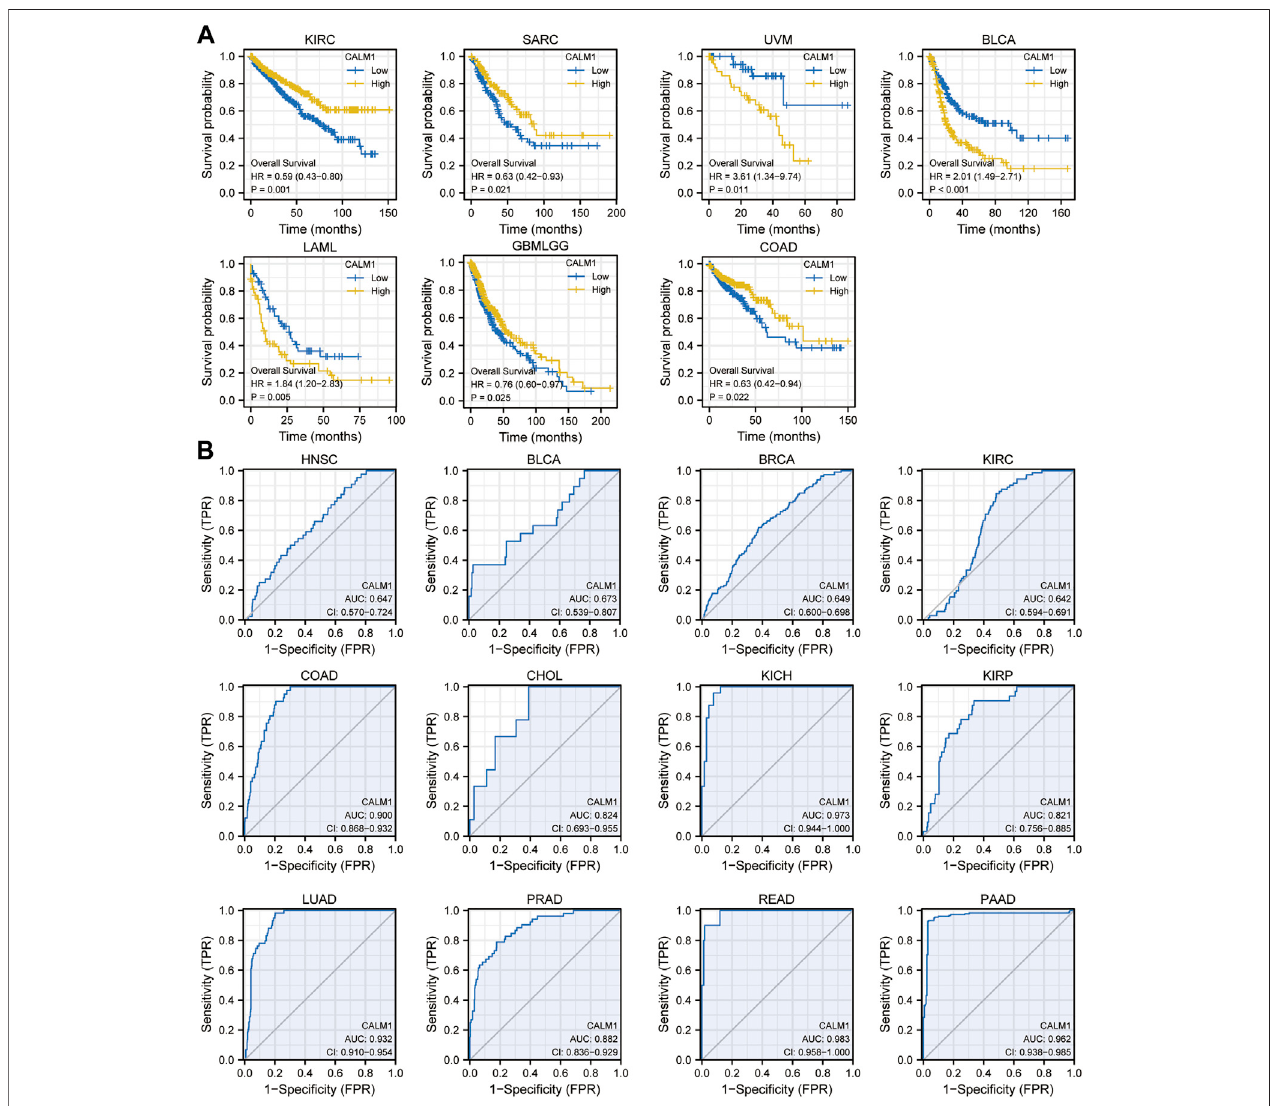
FIGURE 5 | Analysis of prognostic and diagnostic potentials of CALM1 expression in human cancers. (A) Kaplan – Meier survival analysis was conducted to investigate the prognostic value of CALM1 expression. (B) ROC analysis was performed for investigating the diagnostic value of CALM1 expression. HR, hazard ratio; AUC, area under curve; CI, con fi dence interval; ROC, receiver operating characteristic.